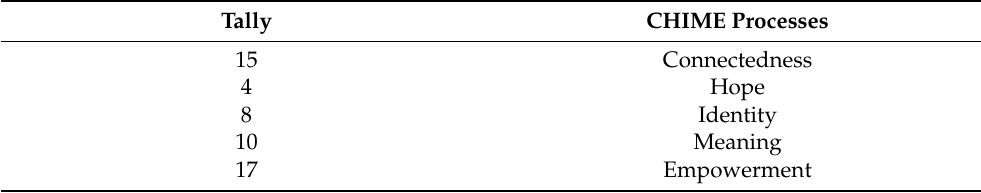
Table 4. Tally of relevance to CHIME